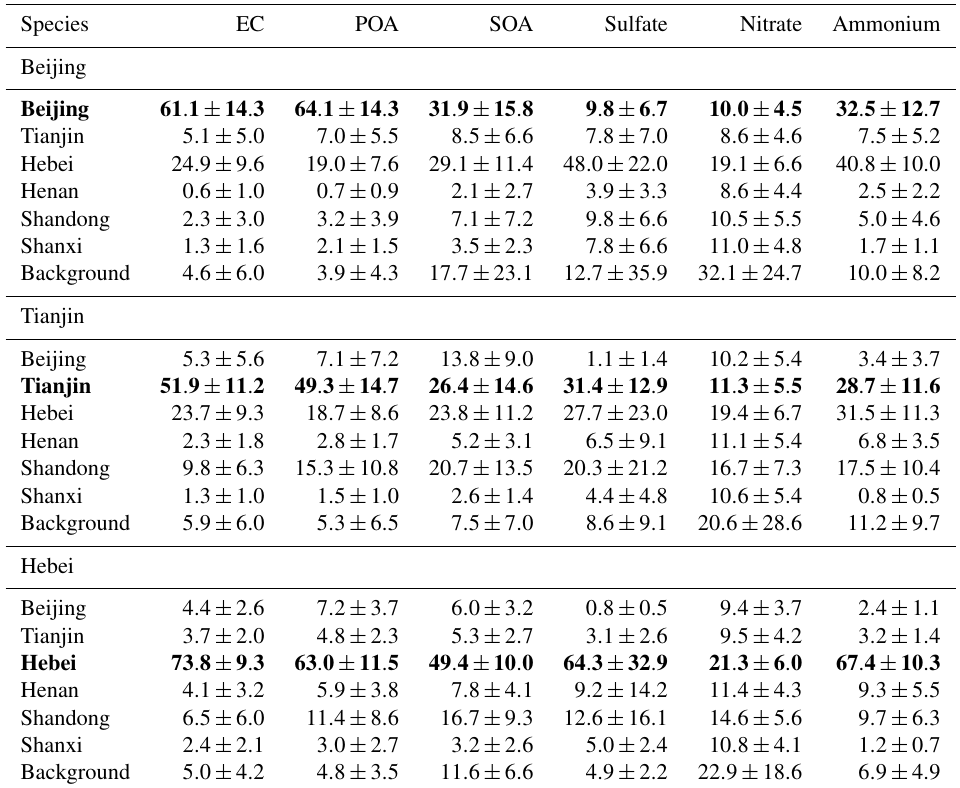
Table 4. Average aerosol constituent contributions (%) in Beijing, Tianjin, and Hebei from local sources, the other five provinces, and the background source from 5 December 2015 to 4 January 2016. The bold font indicates the local